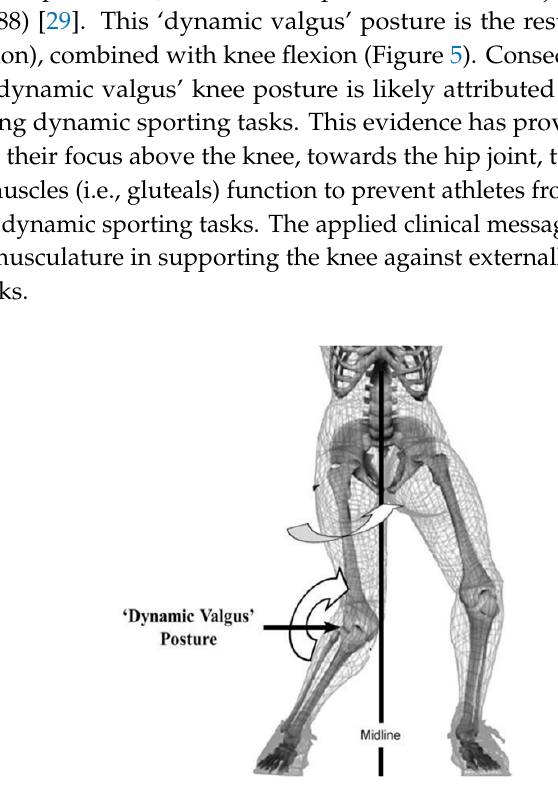
Figure 5. High-risk ‘dynamic valgus’ knee posture, which is a combination of hip internal rotation and abduction combined with knee flexion at impact.